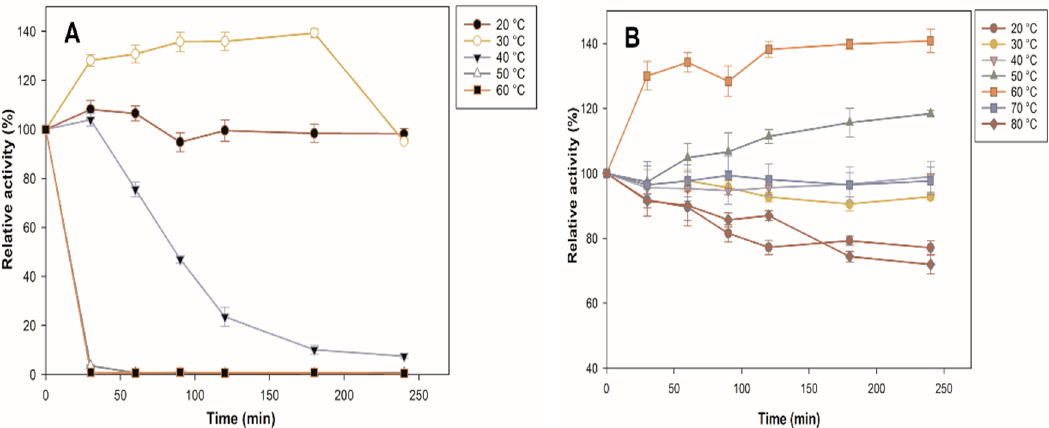
Figure 5. Characterization of β -glucosidase. Effect of temperature on the stability of free ( A ) β and immobilized ( B ) β -glucosidase. All values are the mean of three replicates.